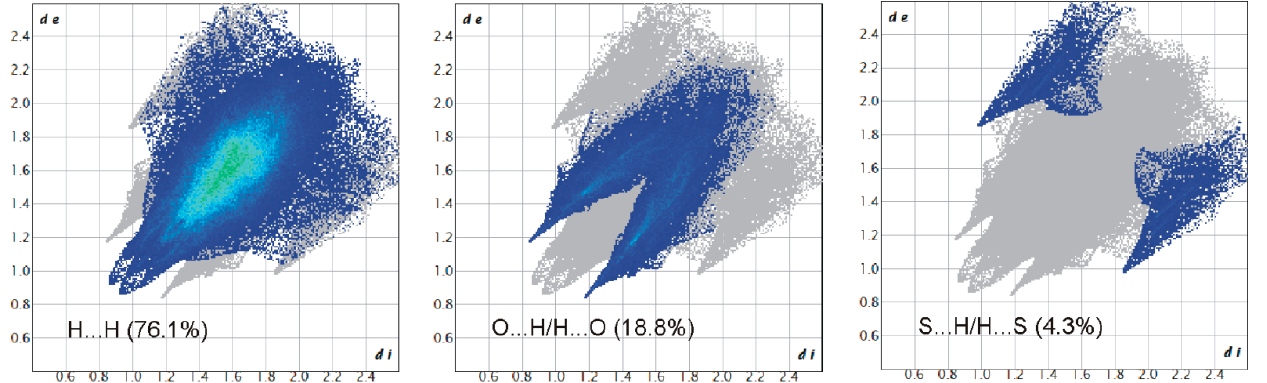
Figure 9. Two-dimensional fingerprint plots for all intermolecular contacts in 2 . The percentage of contribution is specified for each contact.